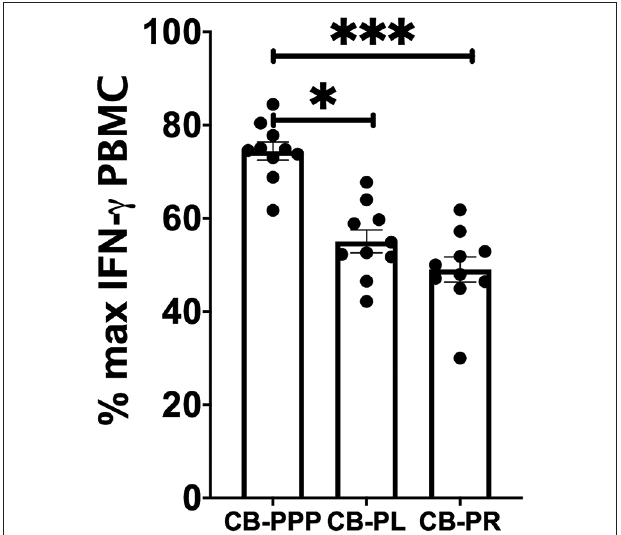
FIGURE 6 | IFN- γ production by PBMCs from healthy donors is reduced by incubation with CB-PPP, CB-PL and CB-PR samples. Results show percentage of maximum IFN- γ expression in culture supernatants relative to complete media following 2h stimulation with PMA and ionomycin. CB-PRP preparations investigated were cord blood platelet poor plasma (CB-PPP; n = 10), cord blood platelet lysate (CB-PL; n = 10), or cord blood platelet releasate (CB-PR; n = 10). PBMCs were incubated with each preparation diluted 50:50 with media and supplemented with IL-2, or with complete media and IL-2 only for 48h prior to antibody staining and flow cytometry analysis. Each experiment was repeated with four different PBMC donors and data points represent donor means. Statistical analysis was performed using non-parametric one-way ANOVA (Kruskal-Wallis test with Dunn’s post-hoc test for unpaired samples and Friedman’s for paired samples). No significant differences between the different CB-PRP preparations were found. * p < 0.05,*** p <